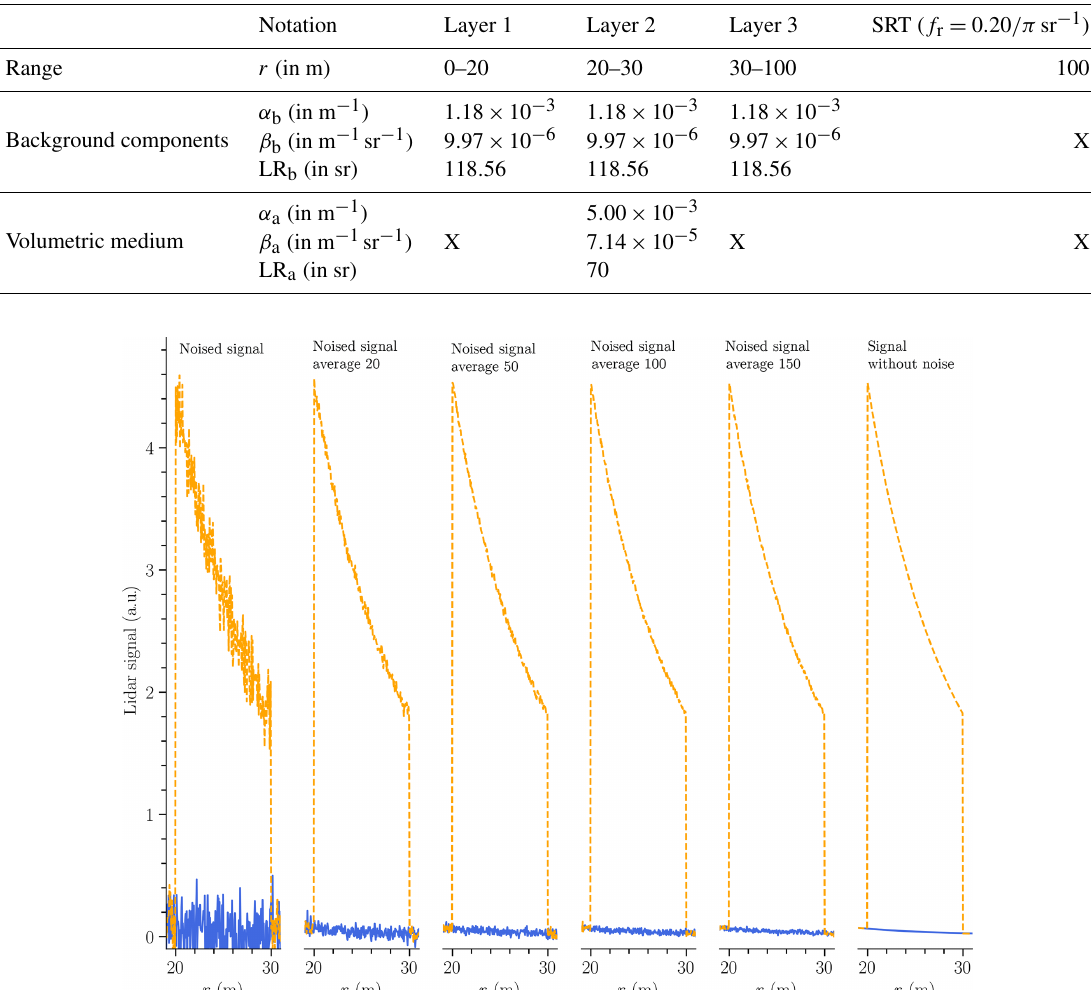
Table 1. Input optical parameters of the scene used in the lidar simulator (PERFALIS code) as illustrated in Fig. 1.